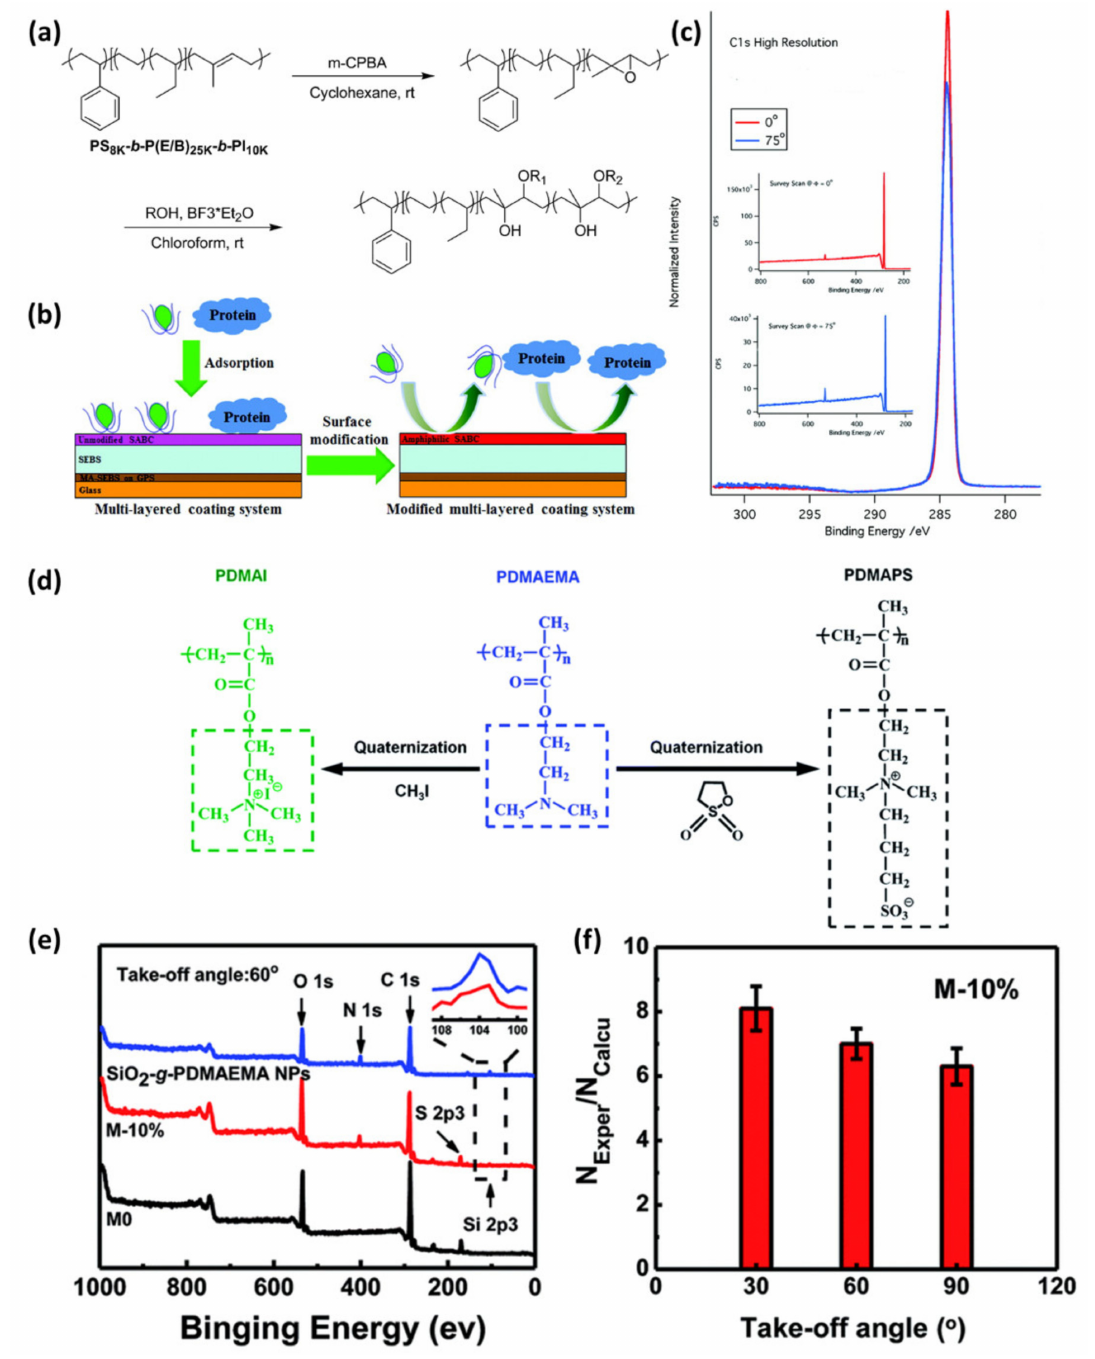
Figure 8. The use of angle-resolved XPS for surface active materials: ( a – c ) the surface-active block copolymers (SABCs) using triblock copolymer (Reproduced with permission from Reference [38]; Copyright (2012) American Chemical Society) and ( d–f ) the nanocomposite of polymer-grafted SiO 2 nanoparticle in polyethersulfone matrix (Reproduced from Reference [40] with permission from the Royal Society of